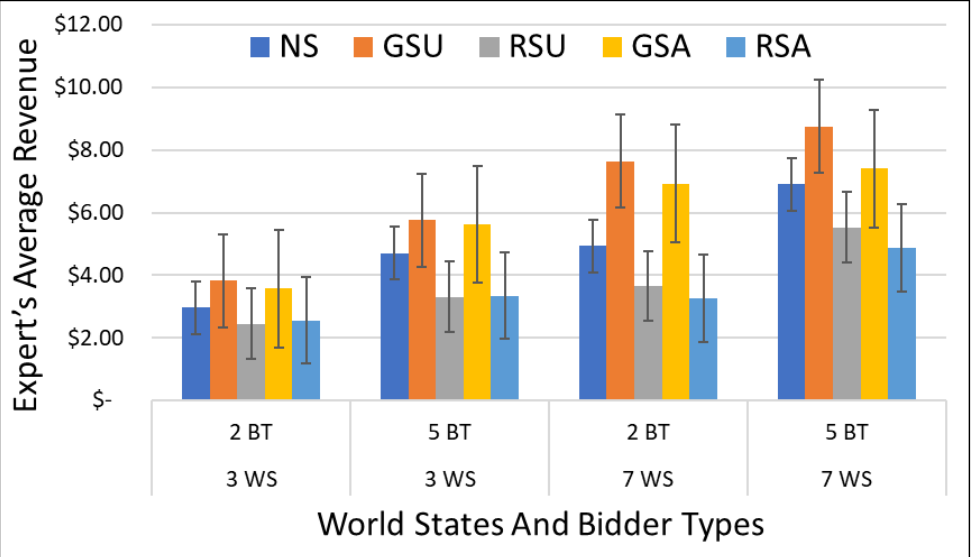
Figure 5. The expert’s average revenue as a function of the number of possible world states and bidder types.